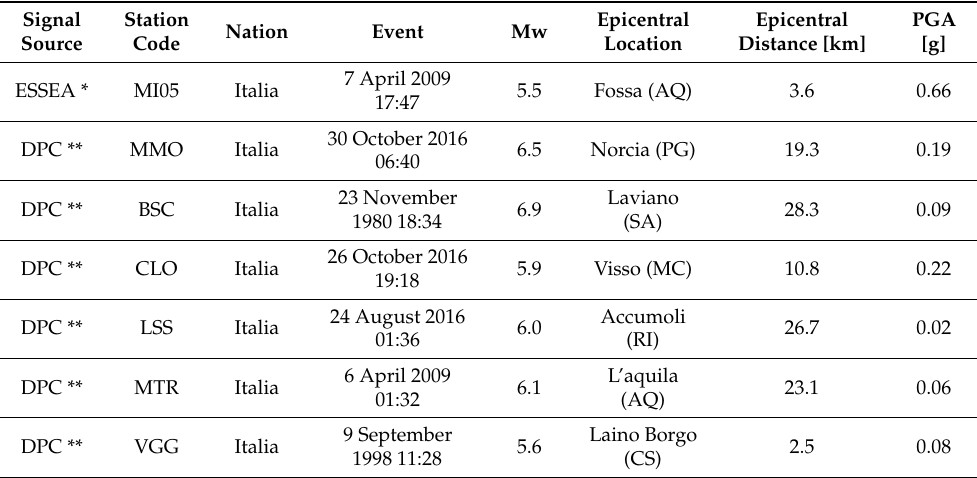
Figure 6. Illustration of the seismic hazard disaggregation, where the percentage contribution to the hazard estimate provided by all possible pairs of magnitude and distance values for a return period of 2475 years is highlighted. Table 4. Selected accelerograms, providing evidence (underlined) of the main and minor events. *Emersito Seismic Network for Site Effect Studies in L’Aquila town, **Italian Strong Motion Network (RAN).